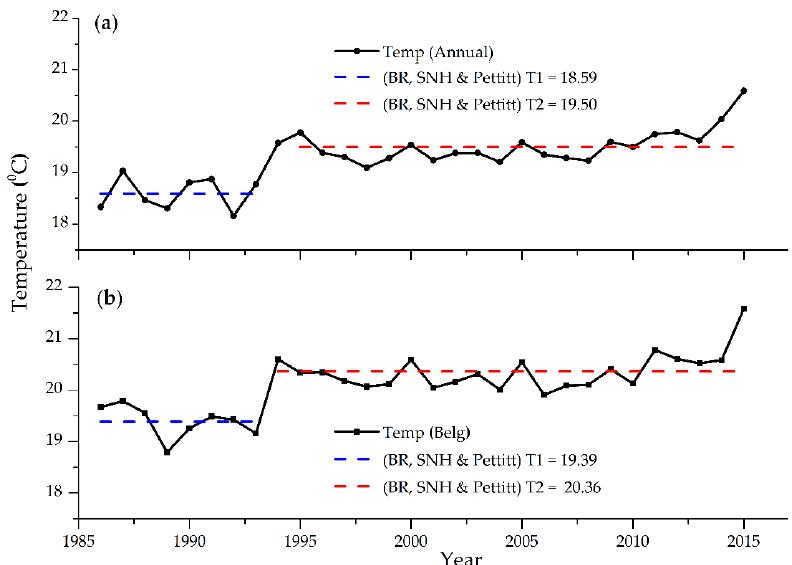
Figure 7. Changing point detection of temperature in the Bilate watershed for the period 1986–2015: ( a ) the annual and ( b ) the Belg season.